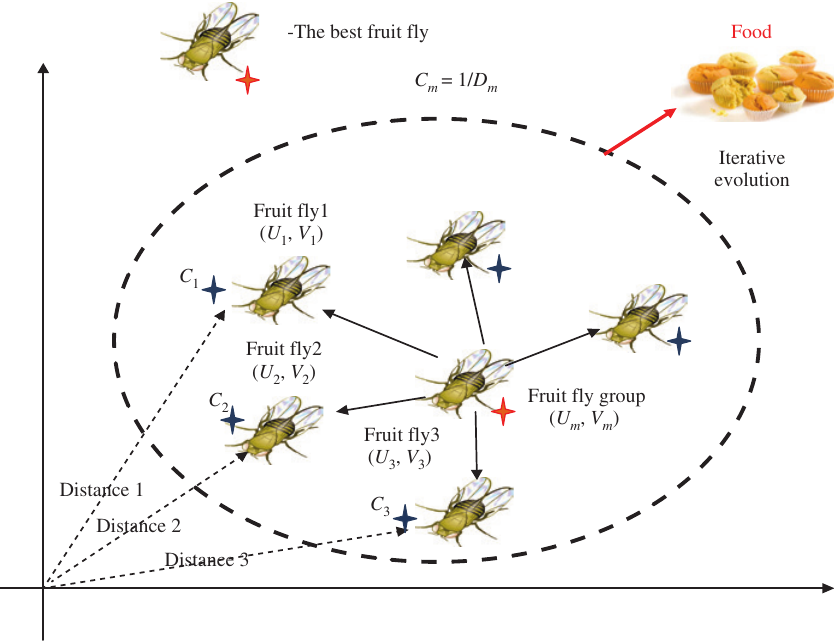
Figure 1: The Interactive Process of Group Iterative Food Searching of Fruit